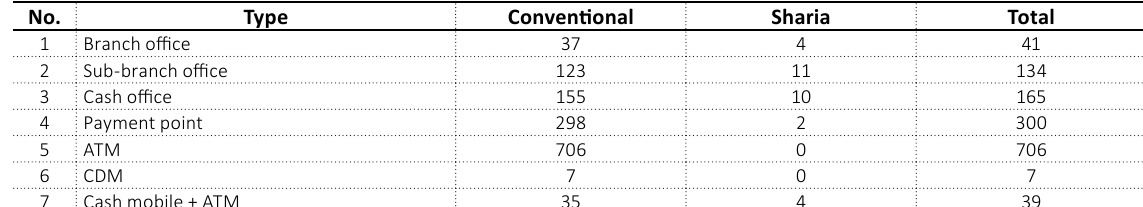
Table 9. Number of STB networks (September 2018)